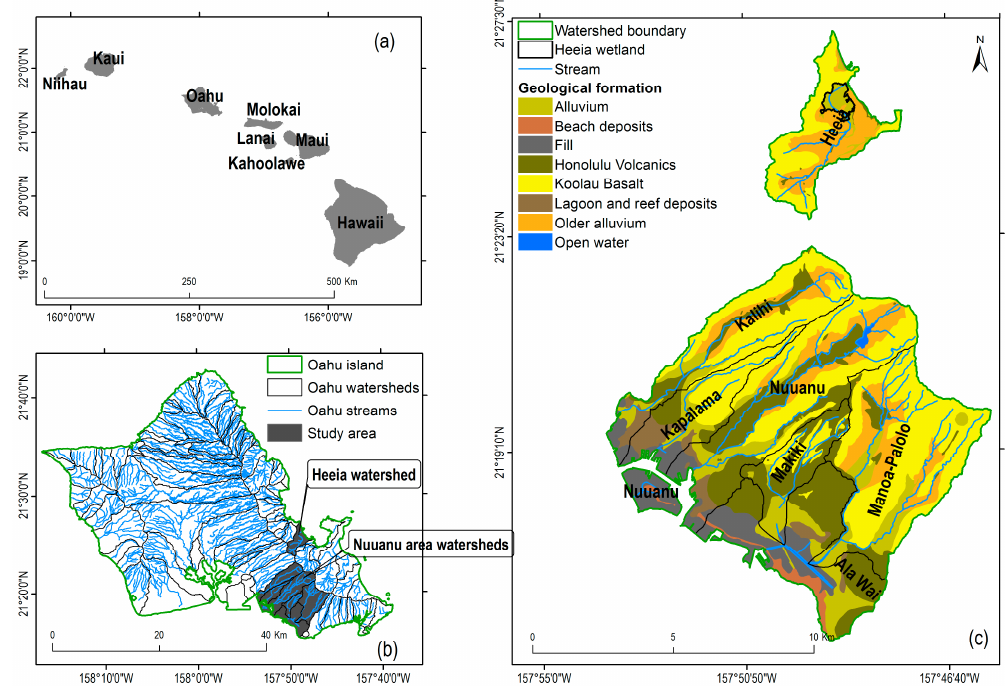
Figure 1. ( a ) the Hawaiian Islands; ( b ) location of the study areas on Oahu Island (solid black lines show watersheds boundaries and blue lines indicate stream networks; and ( c ) the geological formations of Heeia ( top ) and Nuuanu area watershed ( bottom ).